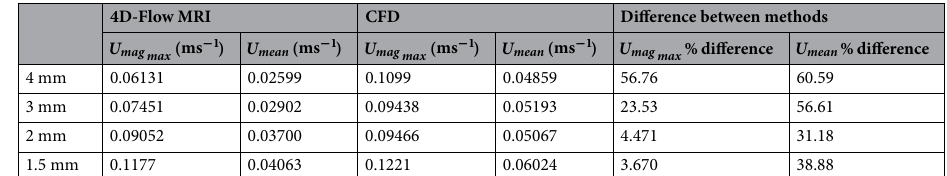
1 ) data at the mid-ascending aortic plane during diastole calculated